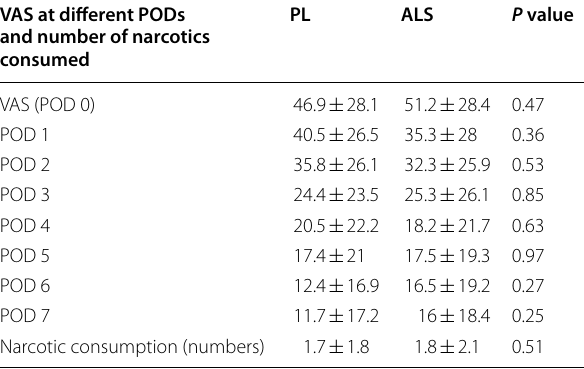
Table 4 Postoperative pain (VAS scale) and narcotic consumption of patients in the PL and ALS